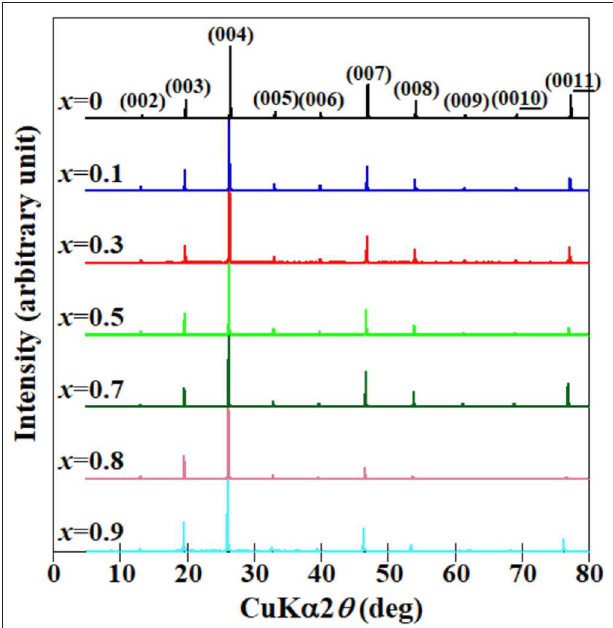
FIGURE 2 | XRD patterns of well-developed plane of (Ce,Pr)OBiS 2 with 0.1 ≤ x ≤ 0.9 and CeOBiS 2 ( x = 0) ( Nagao et al., 2016) single crystals.